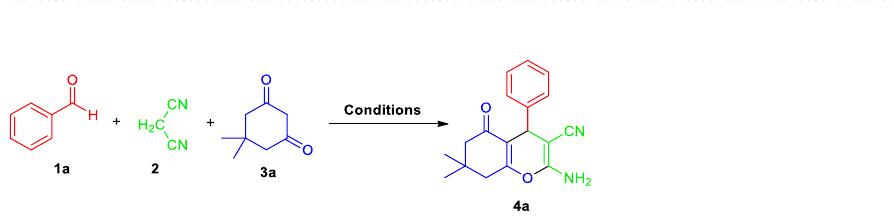
Figure 3. Optimization of reaction conditions for the synthesis of 2-amino-3-cyano-4 H